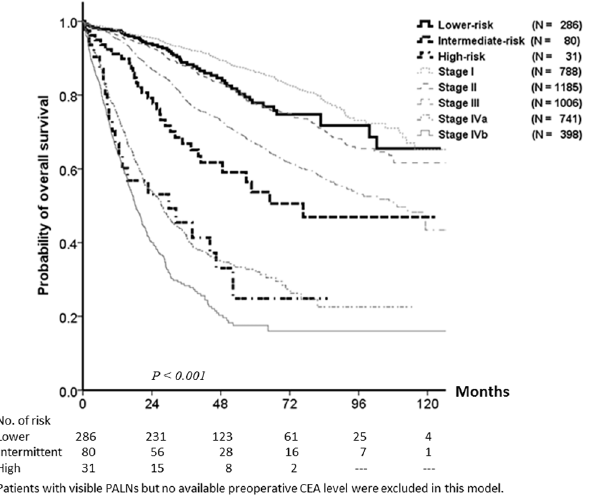
Fig 4. Prognostic model for patients with visible PALNs. The prognostic scoring system scored one point for the presence of each of the following risk factors: lymphovascular invasion, pN+ status, serum carcinoembryonic antigen (CEA) level (cid:1) 10 ng/mL, and short axis diameter of PALNs (cid:1) 10 mm. According to the total prognostic score, patients with visible PALNs were divided into three groups: lower-risk (prognostic score of 0 – 1), intermediate-risk (prognostic score of 2), and high-risk (prognostic score of 3 – 4). 5-year OS of the lower-, intermediate-, and high-risk groups were, 78%, 54%, and 25% respectively ( P < 0.001).